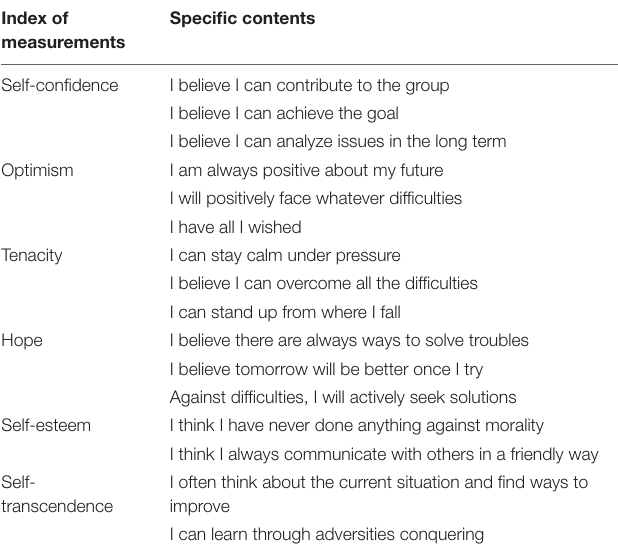
TABLE 2 | The core issues of the designed questionnaire survey (QS) for PsyCap + social and political education (SPE).